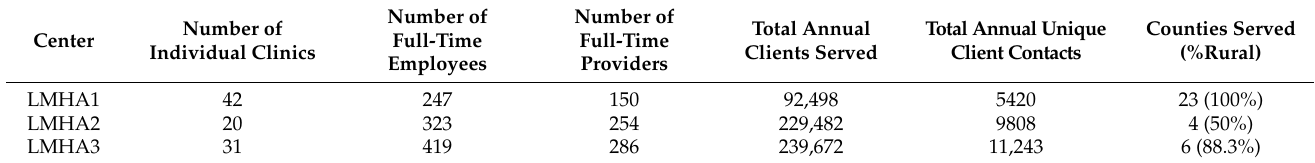
Table 1. Characteristics of participating